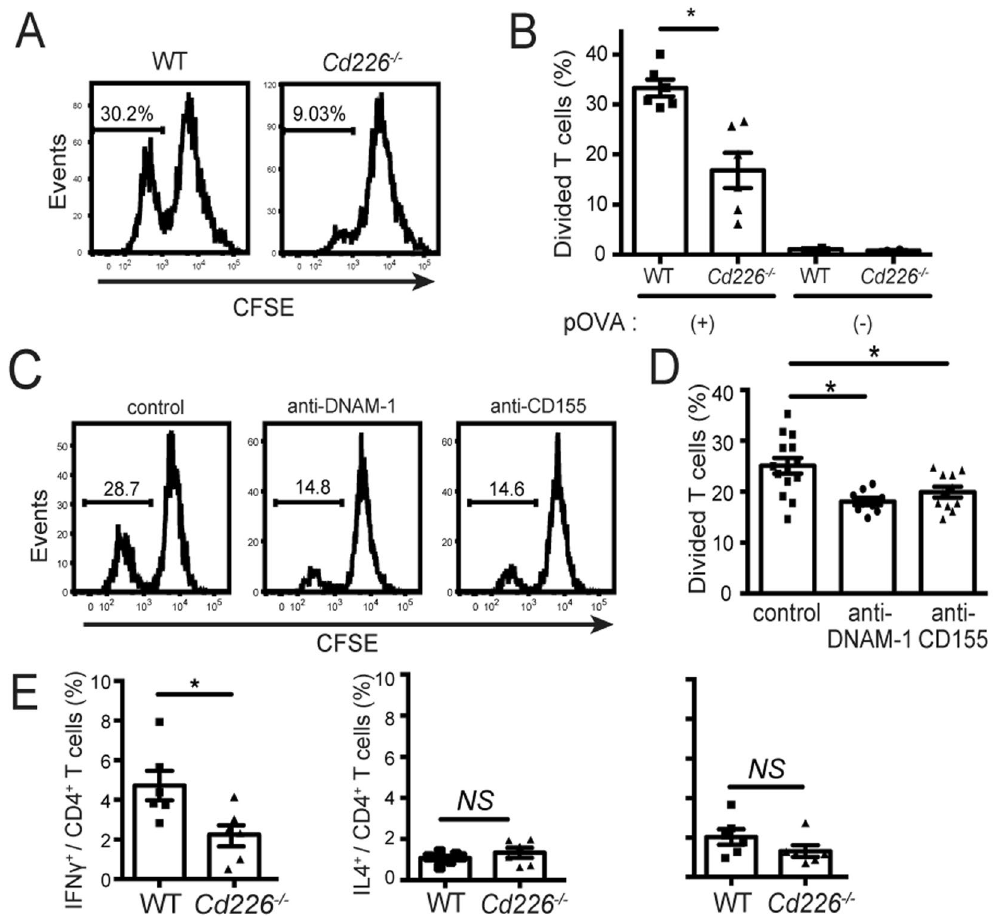
Figure 3. DNAM-1–CD155 interaction is involved in antigen presentation by SPMs. ( A , B ) Naïve CD4 + T cells isolated from OT-II Tg mice were labeled with CFSE and cocultured with SPMs isolated from WT or Cd226 − / − mice in the presence of 1 µ M pOVA. T cells proliferation was assessed by CFSE dilution as mentioned in Fig. 1C,D. Data are representative of four independent experiments. ( C , D ) Naïve CD4 + T cells were cocultured with WT SPMs as mentioned in ( A , B ). Either CD4 + T cells were pretreated with anti-CD155 mAb or SPM were pretreated with anti-DNAM-1. Anti-mouse CD155 mAb (TX56, rat IgG2a) 19 and anti-mouse DNAM-1 mAb (TX42) 18 were generated in our laboratory. T cells proliferation was assessed by CFSE dilution as mentioned in Fig. 1C,D. Data are representative of two independent experiments. Histograms show representative data ( A , C ) and bar graph shows the average of three wells after culture with pOVA ( B , D ). ( E ) After 6 days of coculture as mentioned in ( A , B ), the cells were restimulated by phorbol 12-myristate 13-acetate (PMA) and ionomycine for 4 hrs, then stained with anti-CD4 to distinguish CD4 + T cells with SPMs, and intracellularly stained with anti-IFN γ , anti-IL4 and anti-IL17 to evaluate Th differentiation of CD4 + T cells by flow cytometry analysis. Bar graph shows the average of three wells after culture with or without pOVA (E). Data are representative of two independent experiments. SEM, * P < 0.05. NS , not